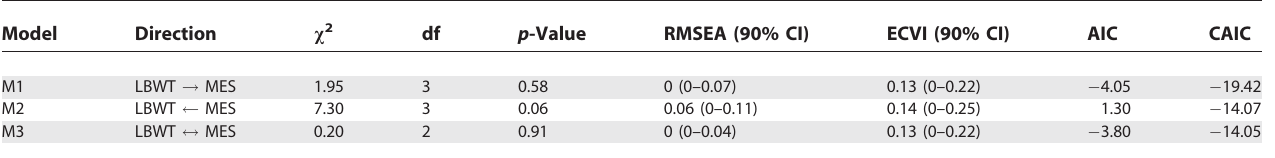
Table 2. Model Comparison for Mesenteric Fat Pad Mass and Lean Body Weight Model